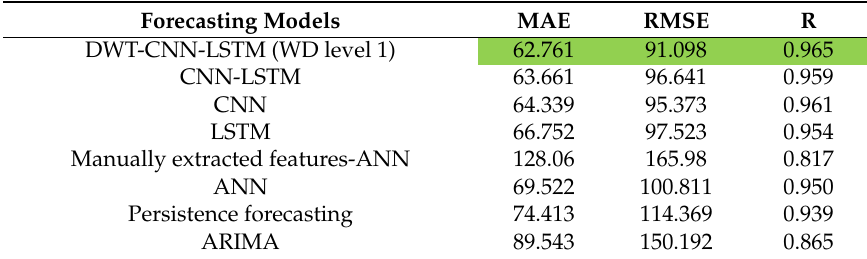
Table 11. The performance comparison of different cloudy days’ forecasting models using the dataset of Desert Rock Station.